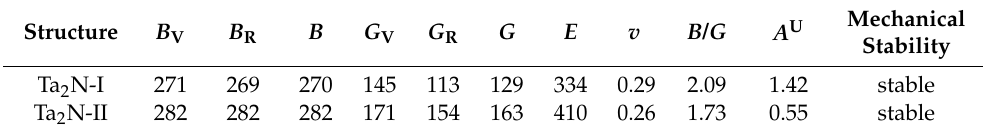
Table 4. The calculated bulk modulus B (GPa), shear modules G (GPa), Youngs’ modulus E (GPa), Poisson’s ratio ν , B / G ratio, universal elastic anisotropic index A U , and mechanical stability of Ta 2 N-I